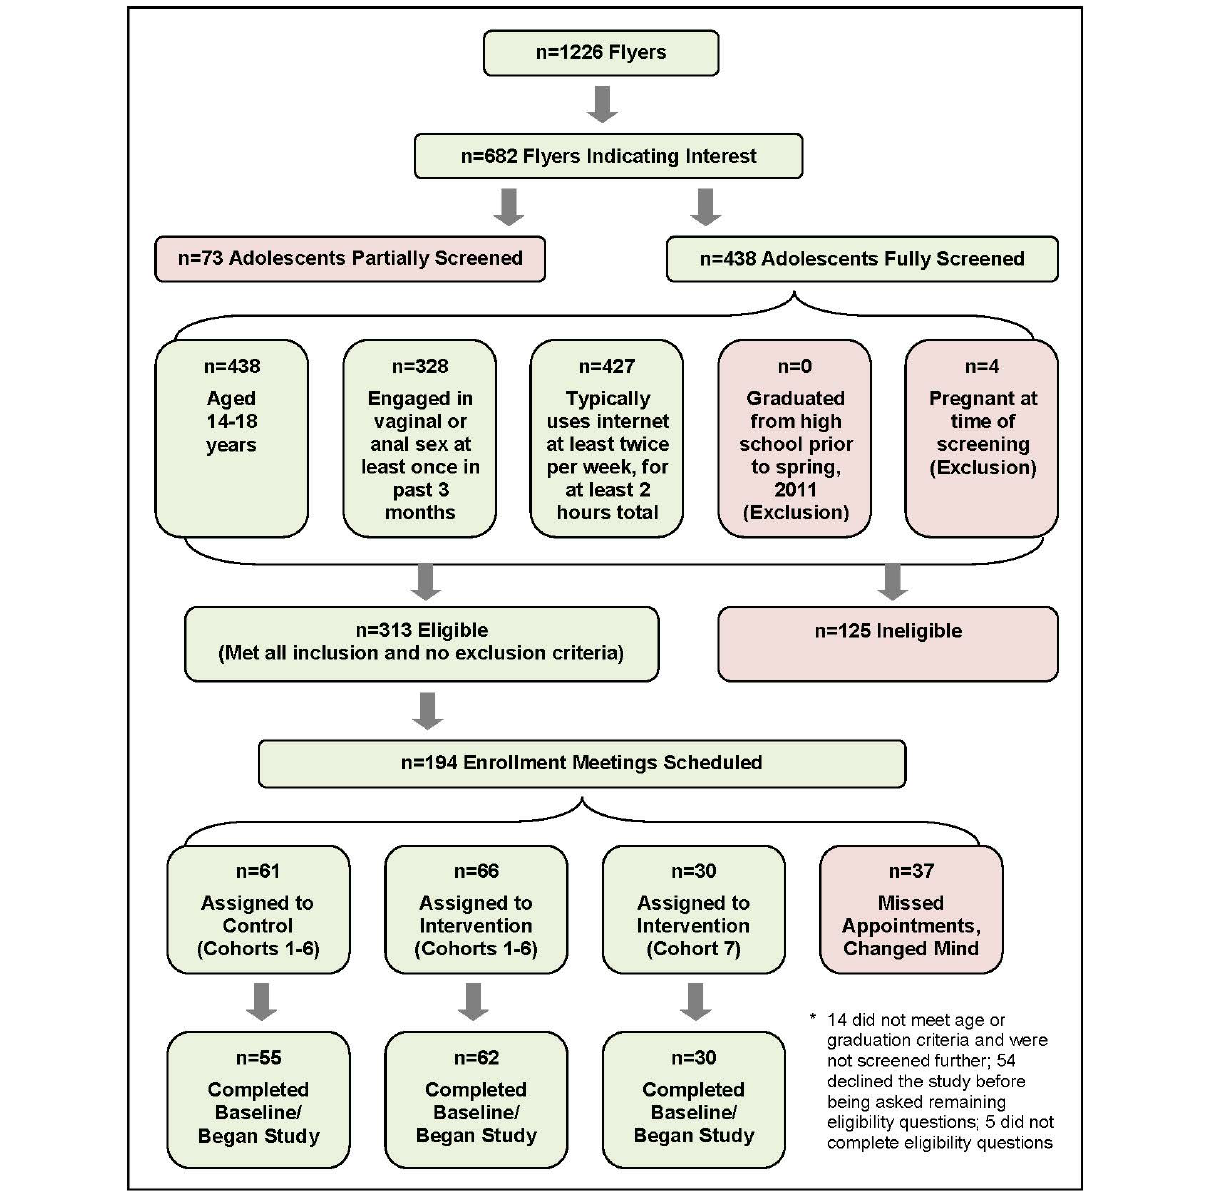
Figure 2. Numbers of adolescents at different stages of recruitment, screening, and